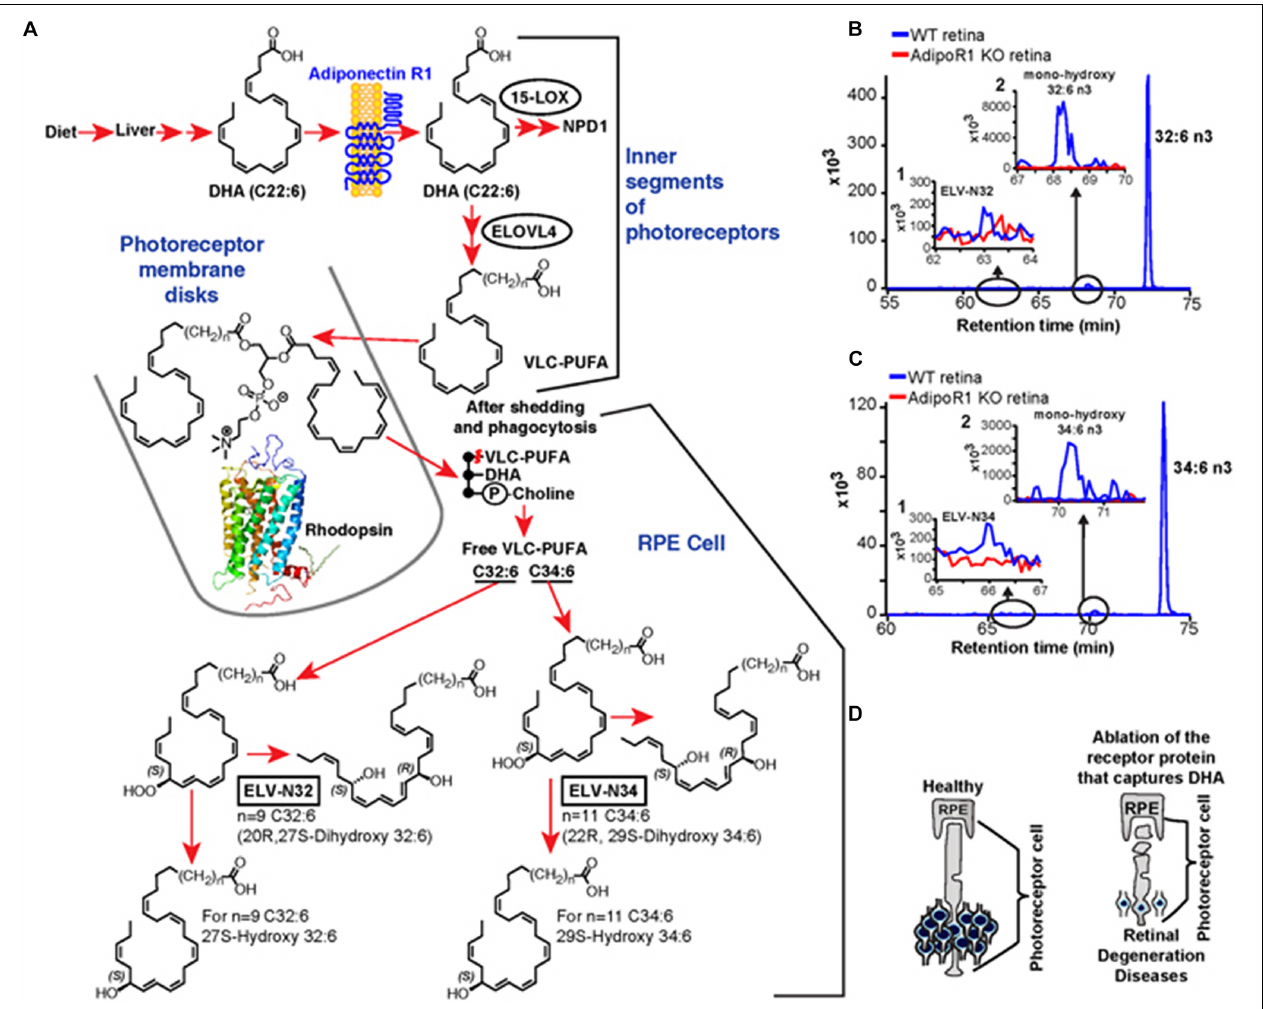
FIGURE 10 | Elovanoid signaling derivatives of VLC-PUFA. Genetic ablation of adiponectin receptor 1 leads to depletion of VLC-PUFAs and its derivatives in retina. (A) Dietary DHA, or that derived from dietary 18:3n3, is supplied by the liver and captured by adiponectin receptor 1 (AdipoR1), followed by elongation in the inner segment of PRC by ELOVL4 to VLC-PUFA and incorporation into phosphatidylcholine molecular species, which also contains DHA. During daily PRC outer segment renewal, these phosphatidylcholine molecular species interact with rhodopsin and, after shedding and phagocytosis, become part of RPE cells. UOS or other disruptors of homeostasis trigger the release of VLC-PUFAs. 32:6n3 and 34:6n3 are depicted generating hydroperoxy forms, and then ELV-N32 or ELV-N34, respectively. (B) The pool size of free 32:6n3 in retinas of AdipoR1 knockout (KO) mice (red) is decreased as compared with that in wild type (WT) (blue). Insert (1) shows ELV-N32 in KO (red) and WT (blue); insert (2) shows mono-hydroxy 32:6n3, the stable derivative of the hydroperoxy precursor of ELV-N32, in WT (blue) and lack of detectable signal in the KO (red). (C) Similarly, the pool size of free 34:6n3 in retinas of AdipoR1 KO mice (red) is decreased as compared with that in WT (blue). Insert (1) shows ELV-N32 in KO (red) and WT (blue); insert (2) shows mono-hydroxy 34:6n3, the stable derivative of the hydroperoxy precursor of ELV-N34, in WT (blue) and lack of detectable signal in the KO (red). (D) RPE cells sustain PRC functional integrity (left); right, the ablation of AdipoR1 switches off DHA availability, and PRC degeneration ensues. Reproduced from Jun et al. (2017) with permission under the Creative Commons Attribution 4.0 International License (link to the Creative Commons license;